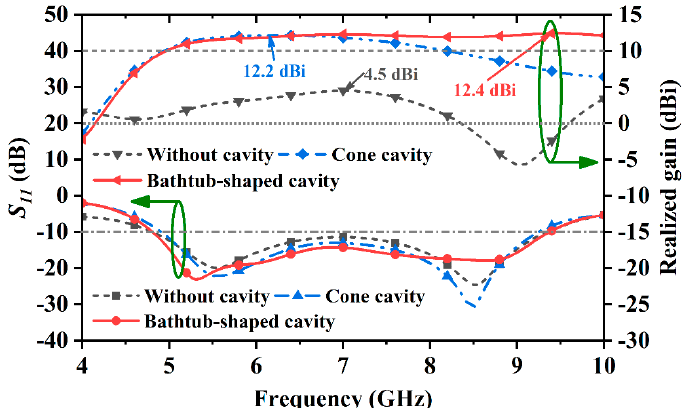
Figure 8. The S 11 and boresight realized gains of the antennas.